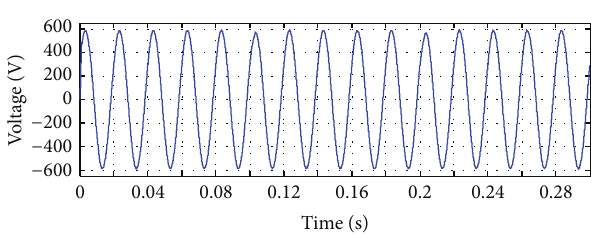
Figure 26: Line voltage ( 𝑉 𝑎𝑏 ) of the three-phase inverter with three load types.